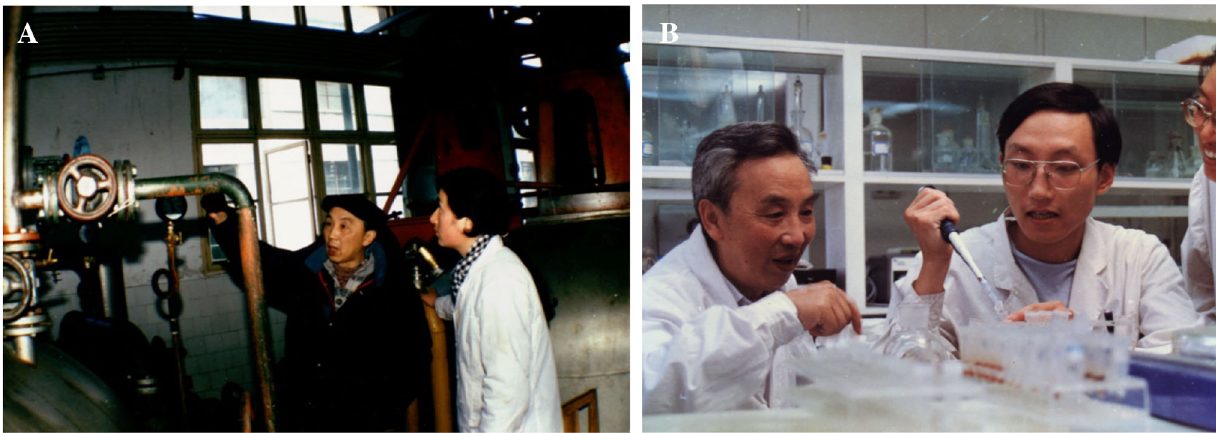
Figure 2. (A) Jilun Li (left) was introducing industrial fermentation technology for a student. (B) Jilun Li (left) worked with